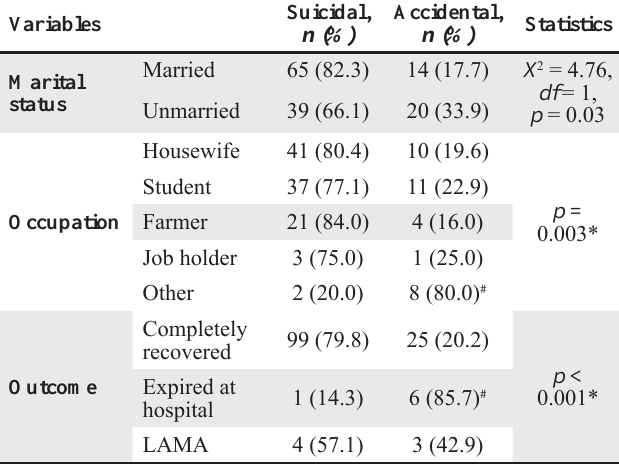
Table 3: Association between manner of poisoning and other variables (N = 138)